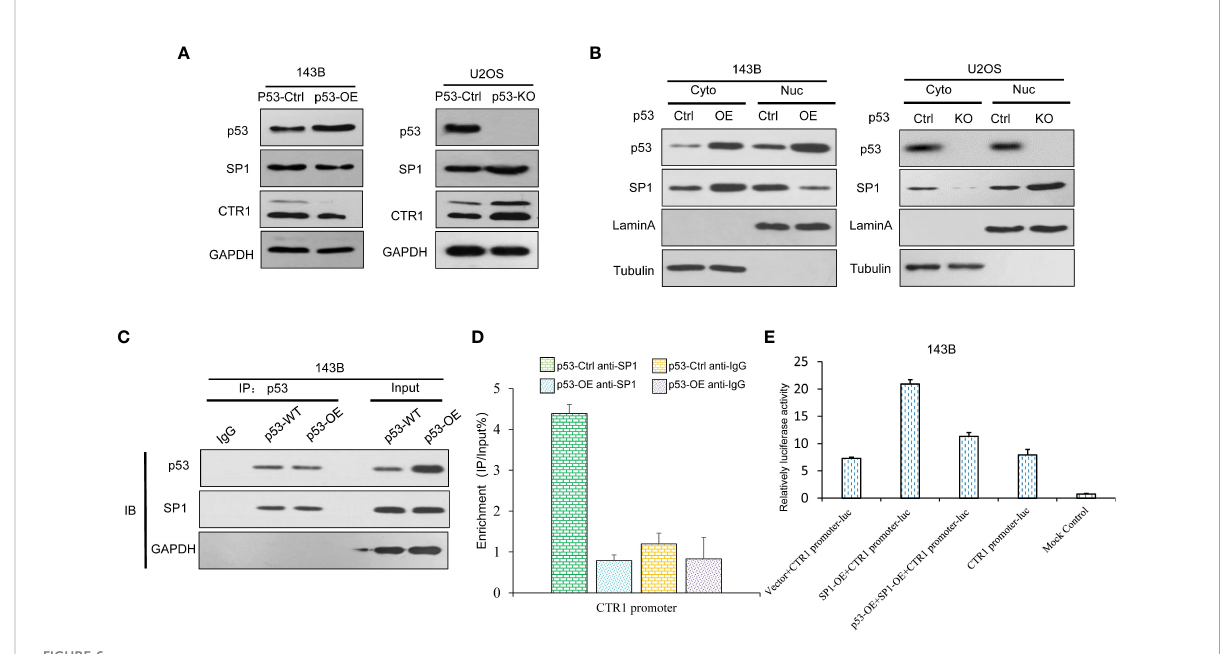
FIGURE 6 p53 suppresses CTR1 transcription by directly binding with SP1 in OS cells. (A) The expression of SP1 was detected by western blot in p53 over-expression (p53-OE) 143B OS cell line and p53 knock-out (p53-KO) U2OS OS cell line. GAPDH was used as the internal control. (B) Nuclear-cytoplasmic separation was utilized to investigate SP1 nuclear translocation in different p53 expression cell lines. The blotting of Lamin A and Tubulin were used as internal control to determine the separation effect. (C) The interaction between p53 and SP1 was determined by Co-IP in 143B cells. Proteins precipitated using anti-Flag antibodies were resolved by SDS-PAGE. (D) The impact of p53 on SP1 binding ability in CTR1 promoter was determined by ChIP assay in different p53-expressing 143B cell lines. (E) The dual-luciferase activity assay was utilized to con fi rm the in fl uence of p53 on SP1 binding ability in 143B cells. Bars show mean ±